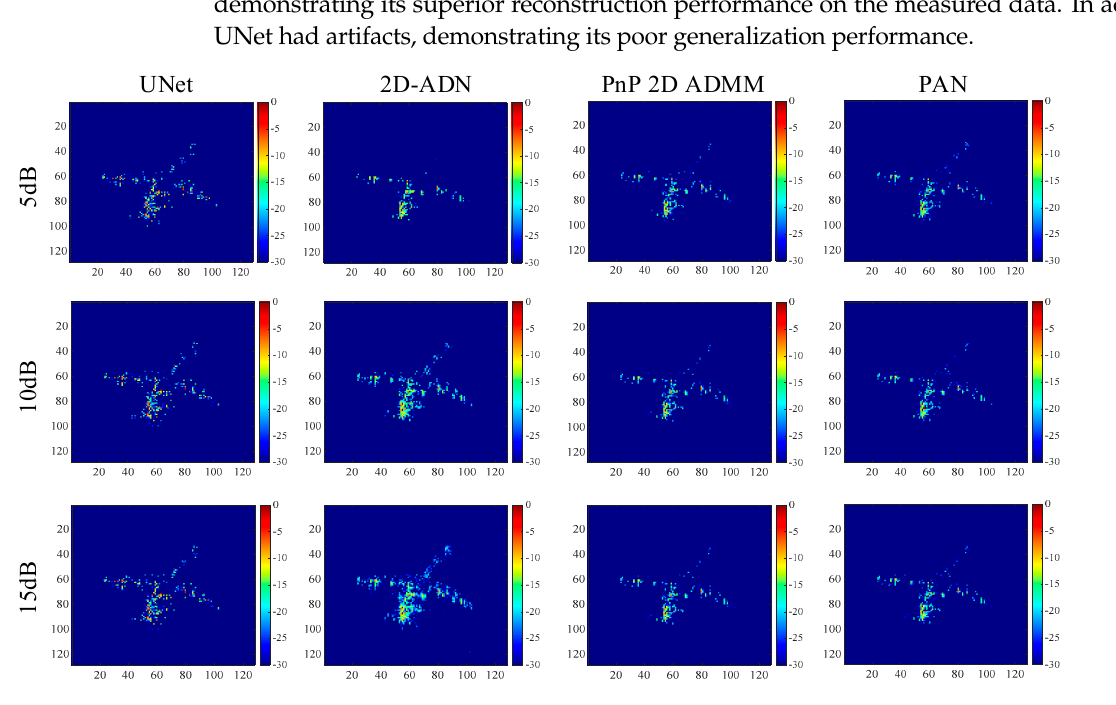
Figure 5. ISAR images of measured data with different SNRs. Table 5. Performance evaluation for the measured 2D incomplete data under different SNR condi- tions.